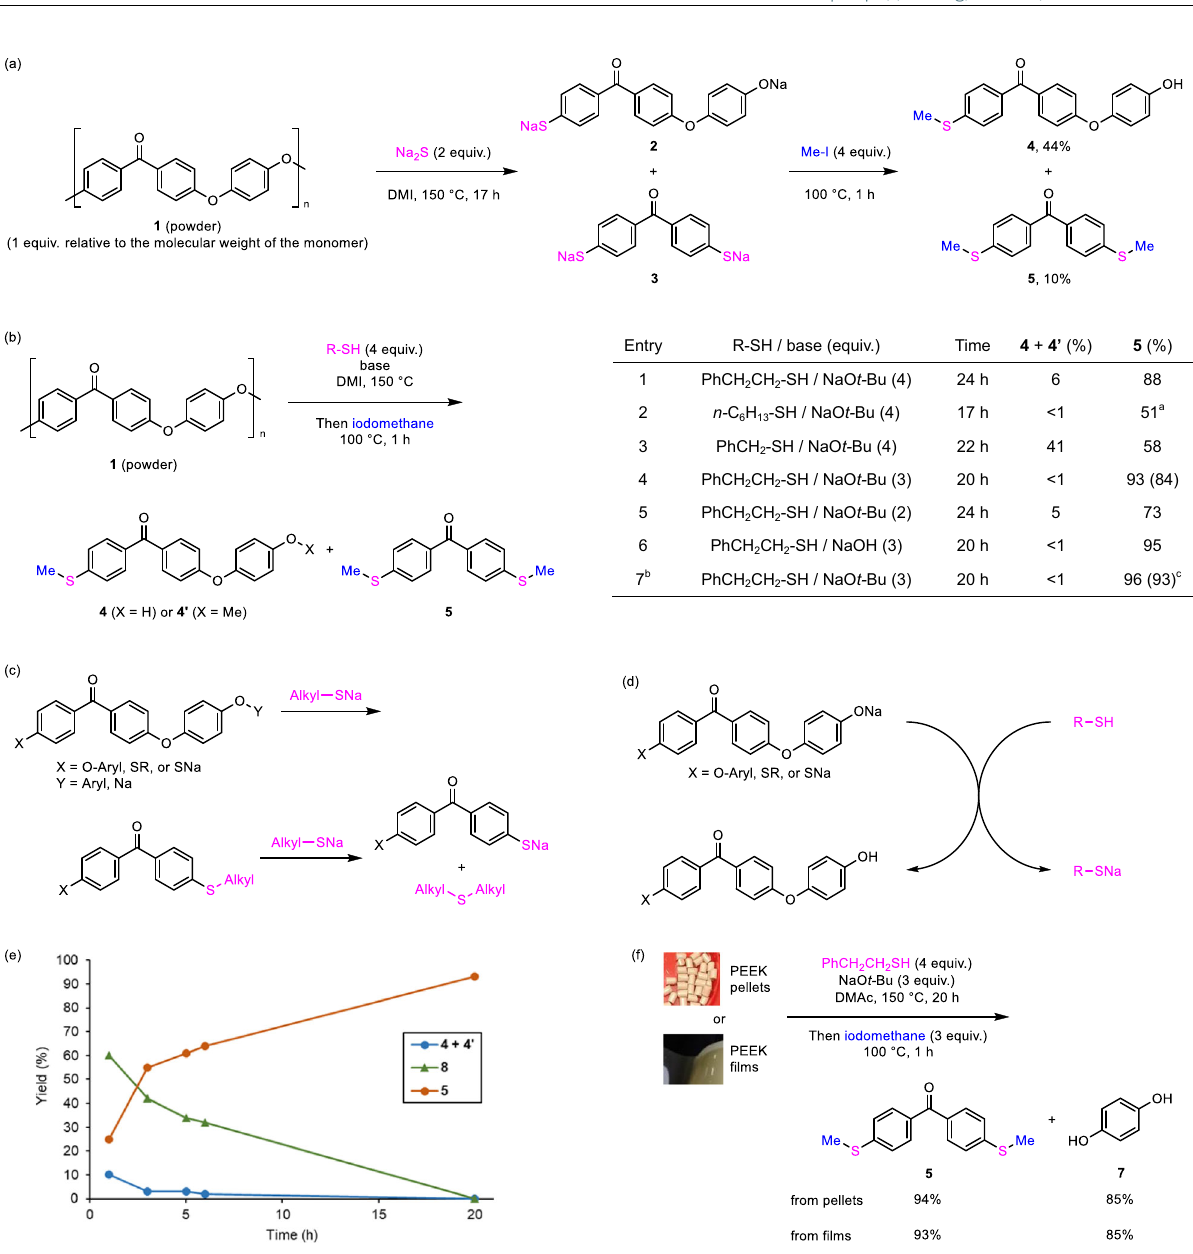
Fig. 2 Development of PEEK depolymerization methodology. a Reaction of PEEK with sodium sul fi de followed by the treatment with